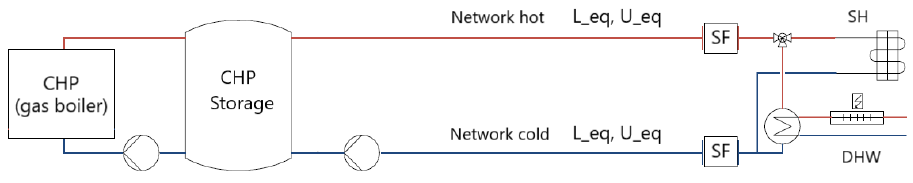
Figure 4. ENaQ HTDH